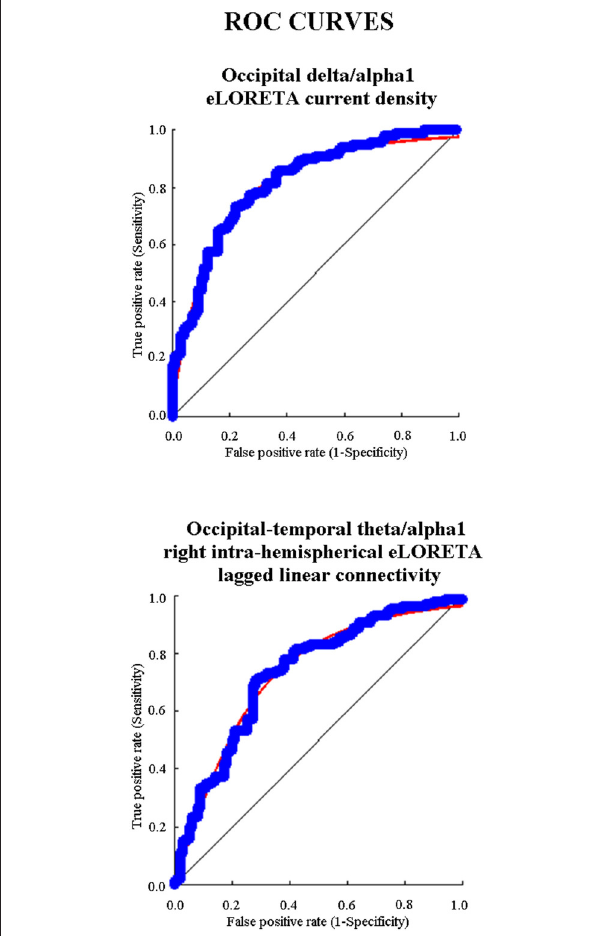
FIGURE 6 | Diagram showing the ROC (receiver operating characteristic) curves that illustrate the performance of the EEG markers with the best classification rate of single Nold and AD individuals. The upper panel shows the best EEG marker for source activity and the bottom panel the best EEG maker for functional connectivity. These EEG markers had an area under the ROC curve (AUROC) higher than 0.70 (i.e., 70%), which is the threshold of a moderate classification performance.